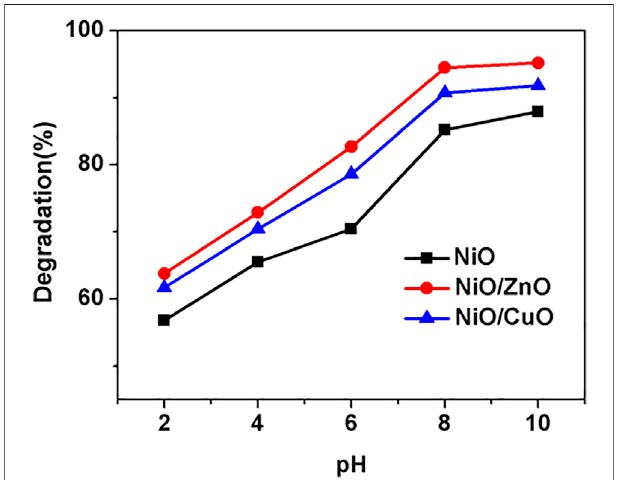
FIGURE 7 | Effect of MB concentration on photocatalytic degradation.